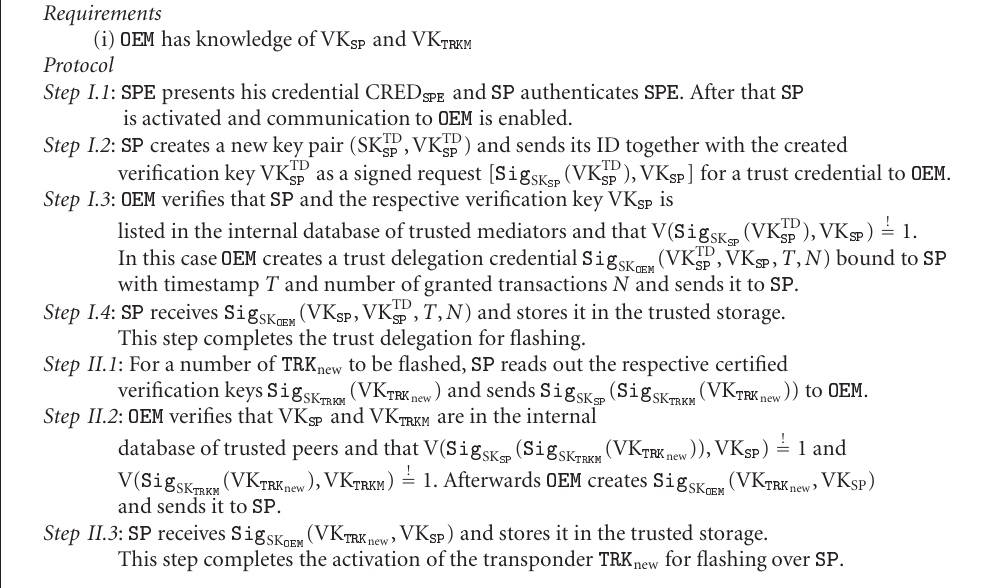
Algorithm 4: Initialization step for mediated key